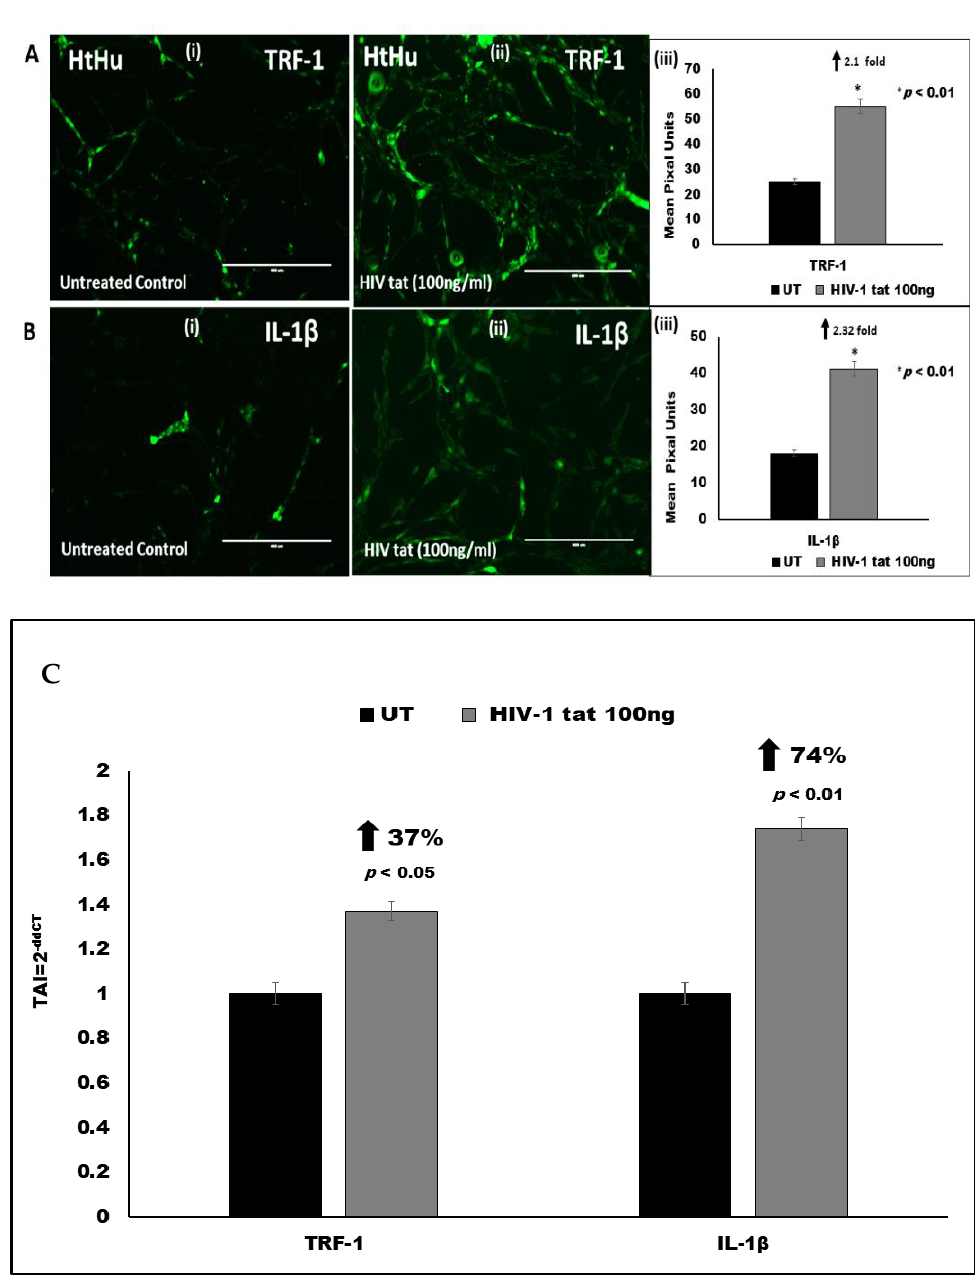
Figure 4. Effect of HIV-tat on TRF-1 and IL1β expression in HTHU microglial cells. ( A ): Immunostaining for TRF-1 expression (green) stained with Alexa Fluor 488 dye; ( A ( i )): Untreated control; ( A ( ii )): HIV tat (100 ng/mL) treated microglial cells; ( A ( iii )): Representative histogram of quantitation of fluorescent signal showing TRF-1 expression by Image J. ( B ): Immunostaining for IL-1β expression (green) stained with Alexa Fluor 488 dye; ( B ( i )): Untreated control; ( B ( ii )): HIV tat (100 ng/mL) treated microglial cells; ( B ( iii )): Representative histogram of quantitation of fluorescent signal showing IL-1 β expression by Image J. Expression was quantitated using ImageJ software and statistical analysis was performed based on comparison between treated and untreated control. A p value of <0.05 is considered a statistically significant difference. Standard immunostaining protocols were followed. Results shown are representative images from ( n = 3) separate experiments. ( C ): Effect of HIV-tat and cART on Telomerase gene expression in HTHU and HTHU/HIV as quantitated by QPCR. Results are expressed as the mean ± SD from separate experiments ( n = 3) done in triplicate. A p value of <0.05 is considered a statistically significant